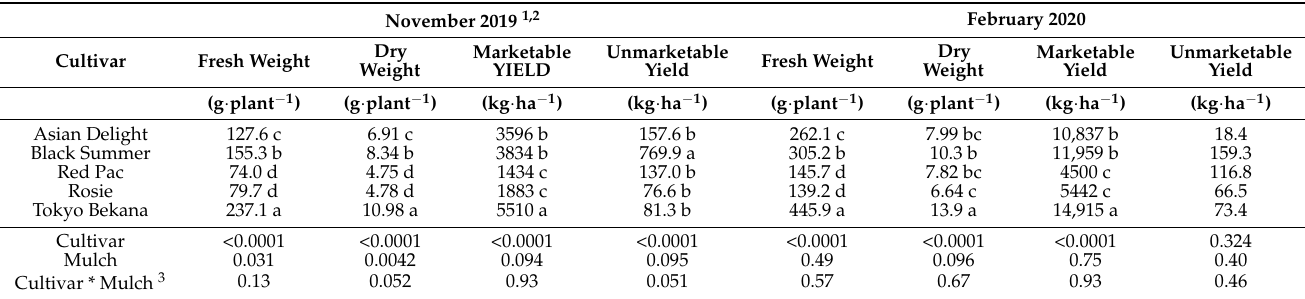
Table 3. Fresh, dry plant weights, and yields of five Asian green cultivars grown in a high tunnel with four types of mulches in Starkville, MS in two experiments.